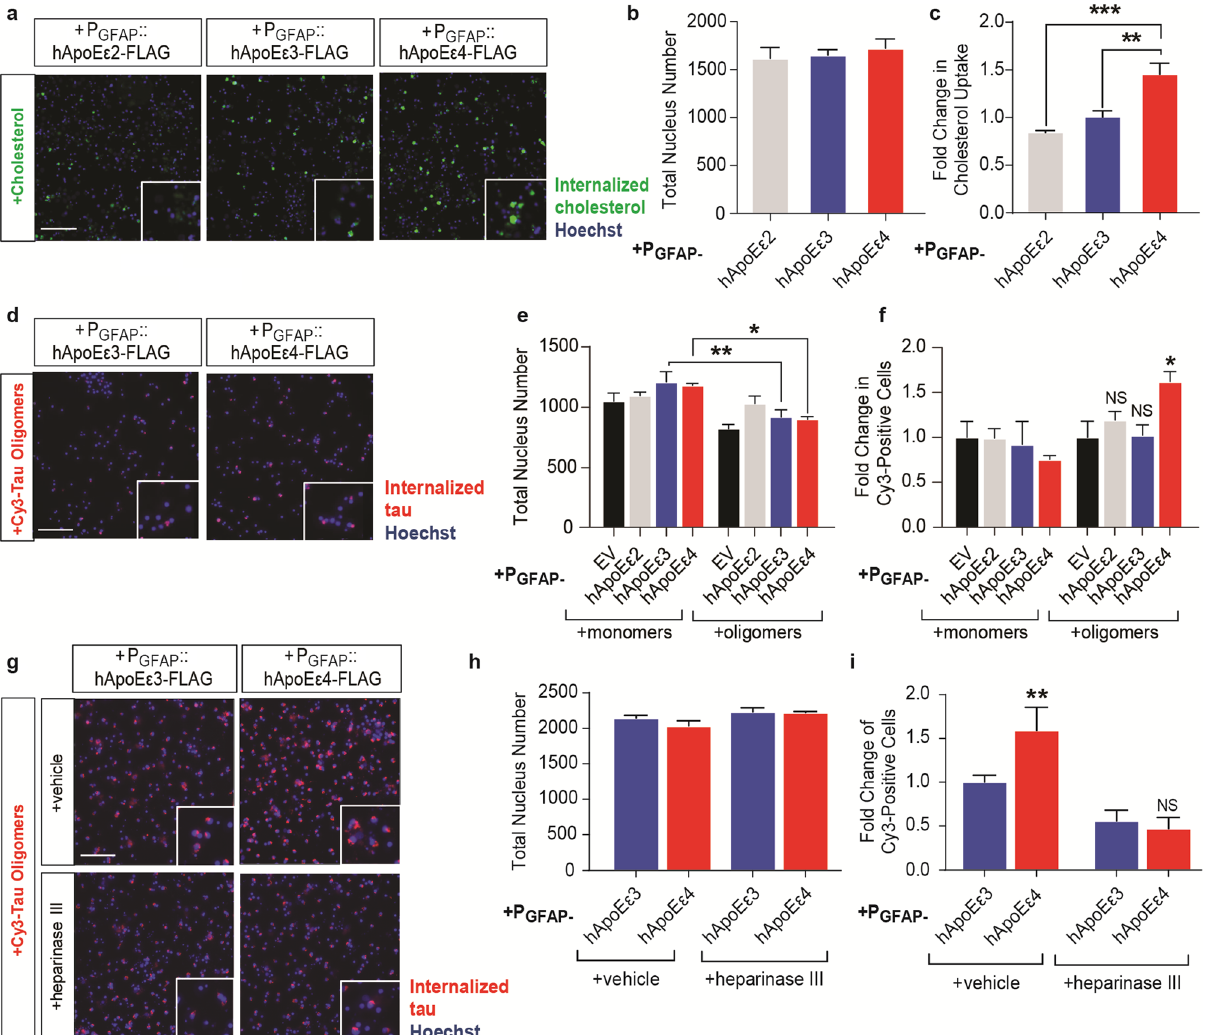
Figure 4. Astrocytic hApoEε4 alters the dynamics of cholesterol and tau oligomer accumulation. Scale bar of representative images represents 50 µM. High-content imaging and its associated quantification represents data from one independent experiment. (a) Representative live-cell imaging of GFP-labeled cholesterol internalization one day following a 4-h incubation in co-cultures. Hoechst stain was used to visualize nuclei. (b) Quantification of Hoechst-labeled nuclei ( n = 6 wells/group) in panel (a) . (c) Quantification of the total GFP (cholesterol) intensity in the cytoplasm of cells by high-content image analysis. Data are depicted as fold change over P GFAP ::hApoEε3 group ( n = 6 wells/group). ** p < 0.01, *** p < 0.005, Tukey’s multiple comparisons test following one-way ANOVA. (d) Representative live-cell imaging of cy3-tagged tau internalization 24 h following cy3-tau addition. Hoechst stain was used to visualize nuclei. (e) Quantification of Hoechst-labeled nuclei by high-content imaging ( n = 5 wells/group). * p < 0.05, ** p < 0.01, Tukey’s multiple comparisons test following one-way ANOVA. (f) Quantification of the number of cy3-positive cells. Data are depicted as the fold changes over respective monomer or oligomer-treated P GFAP ::EV groups ( n = 5 wells/group). NS not significant, * p < 0.05, Tukey’s multiple comparisons test following one-way ANOVA. (g) Representative live-cell imaging of cy3-tagged tau internalization 24 h following tau addition. Cells were pre-treated with vehicle or 150 mU heparinase III for four hours prior to cy3-tau oligomer addition. Hoechst stain was used to visualize nuclei. (h) Quantification of Hoechst-labeled nuclei by high-content imaging ( n = 3 wells/group). (i) Quantification of the number of cy3-positive cells. Data are depicted as the fold change over P GFAP ::hApoEε3 + vehicle group ( n = 3 wells/group). NS not significant, ** p < 0.01, Fisher’s LSD test following one-way lesterol levels remaining one day after cholesterol addition in hApoEε4 co-cultures compared to hApoEε2 and hApoEε3 co-cultures ( p = 0.0002, one-way ANOVA) (Fig. 4c). Given the change in the uptake and/or clearance of cholesterol molecules within cells, it was not known whether hApoEε4 may also alter the dynamics of uptake and/or clearance of tau. Clinical evidence shows that tau pathology may spread through axonally connected brain regions 59 . Based on the prion hypothesis of tau transmission, our laboratory previously established a model where internalized tau oligomers were shown to